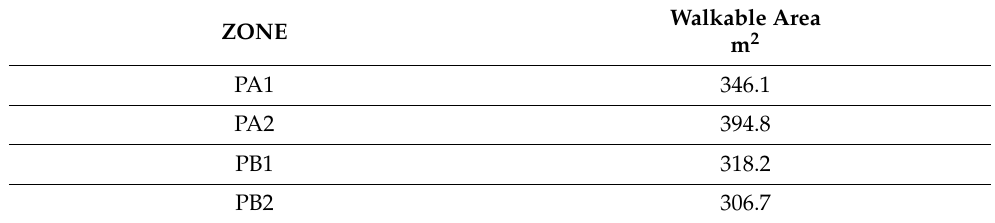
Table 3. Available Pedestrian Space.